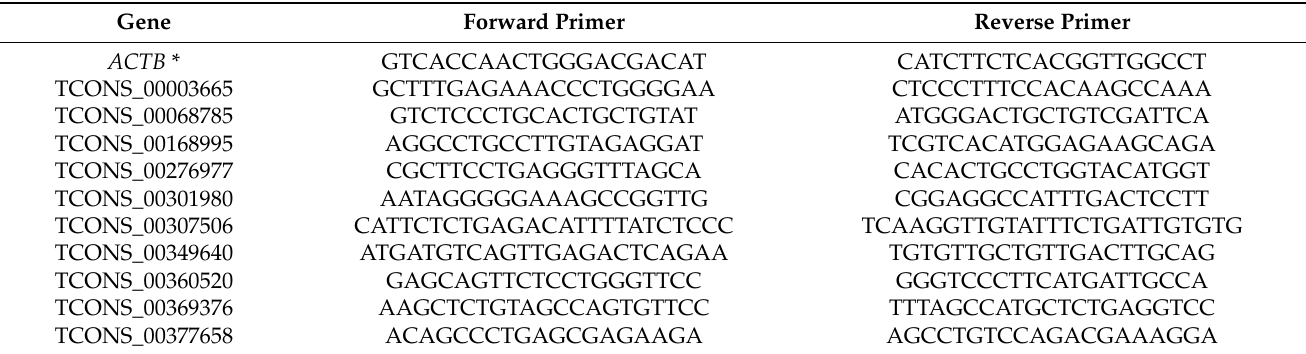
Table 1. Primer sequences for qRT-PCR